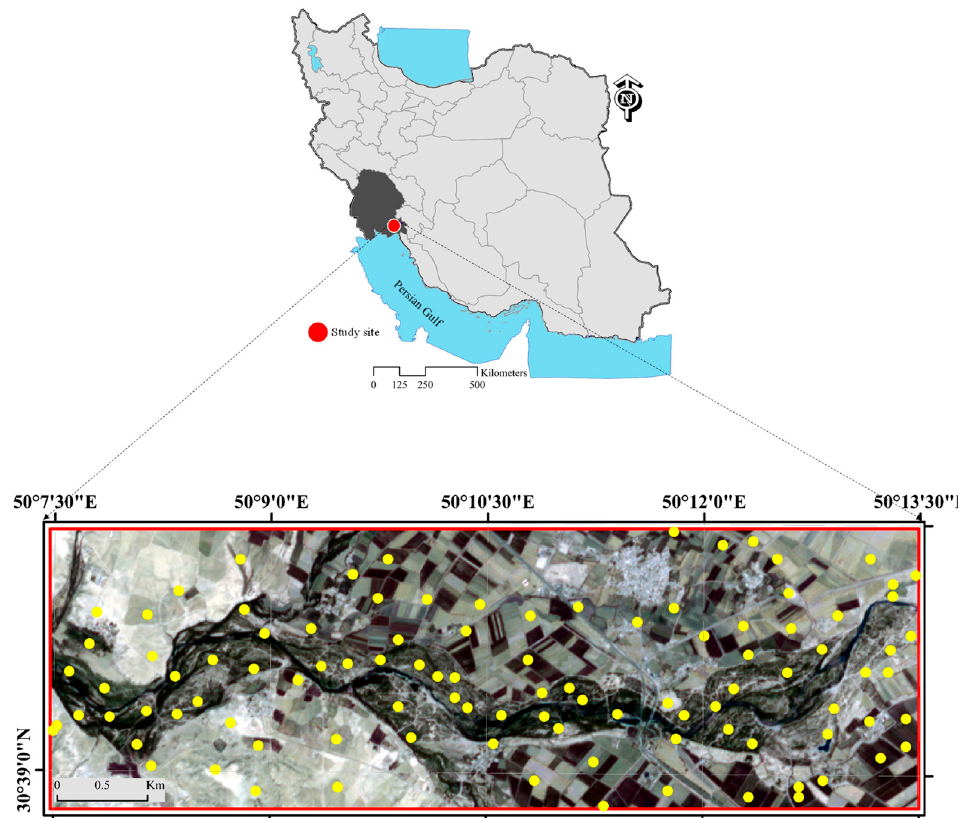
Figure 2. Study site location and spatial distribution of sampling points (yellow dots) in the studied site on Sentinel 2 satellite image.